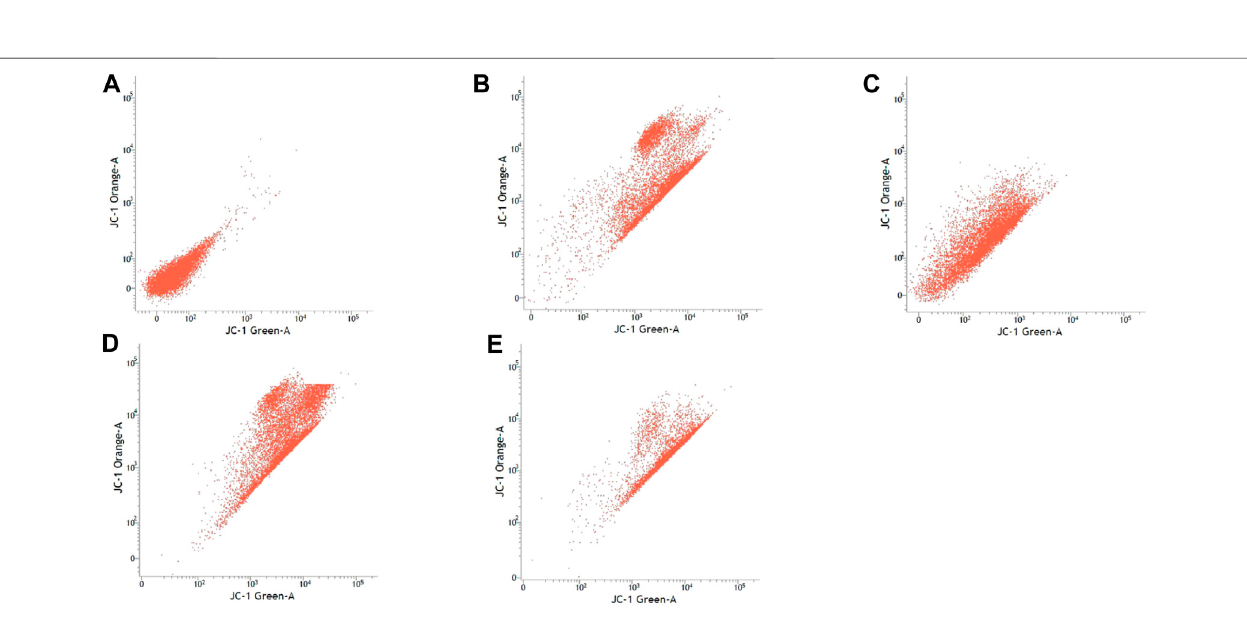
Frontiers in Pharmacology |